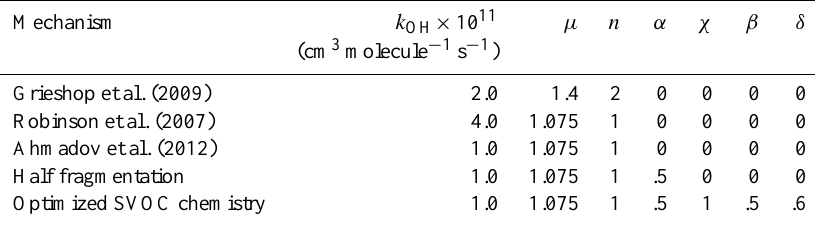
Table 2. SVOC chemistry parameters in the mechanisms studied here; see Reactions (R3) and (R4) for definitions of the parameters.